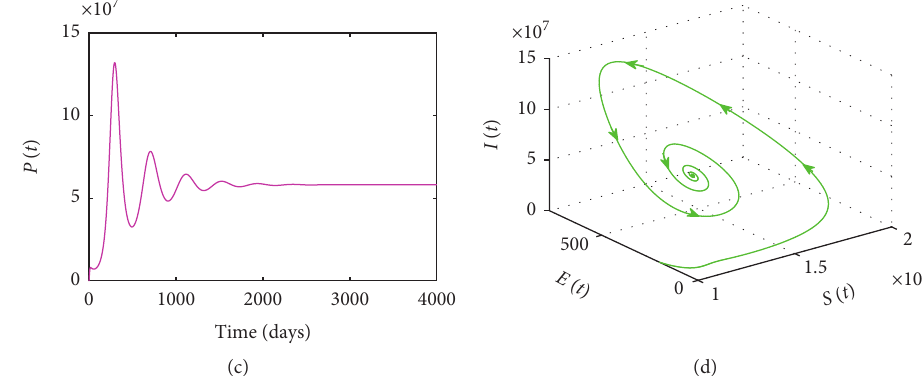
Figure 2: Numerical results of system (1) depicting the persistence of the disease of R Parameter values used to construct the simulations are in Table 1, with p � 0 . 01 and κ � ϵ � 0, leading to R